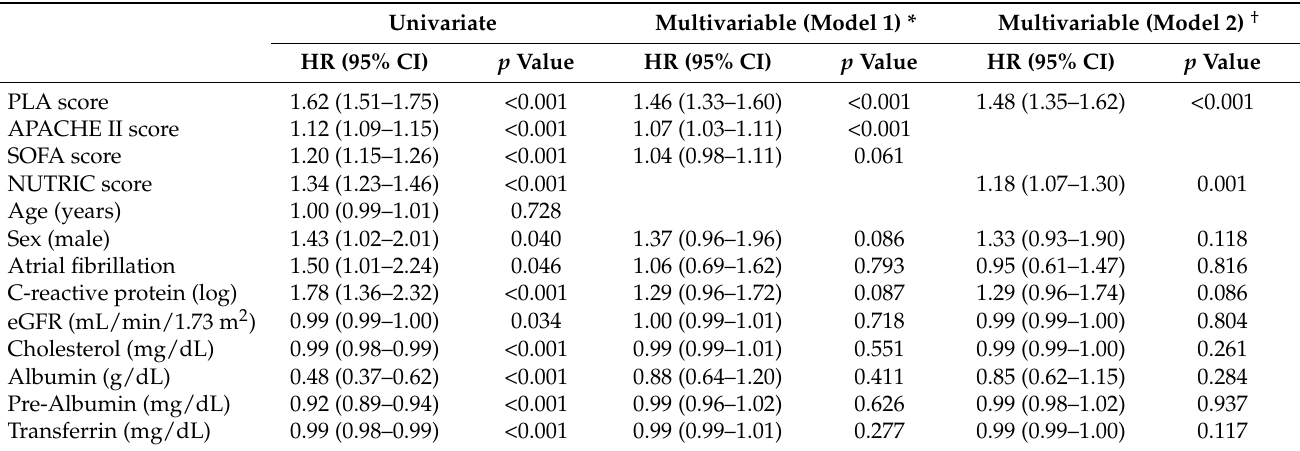
Table 4. Cox univariate and multivariable analysis for predicting 30-day mortality in the initiation